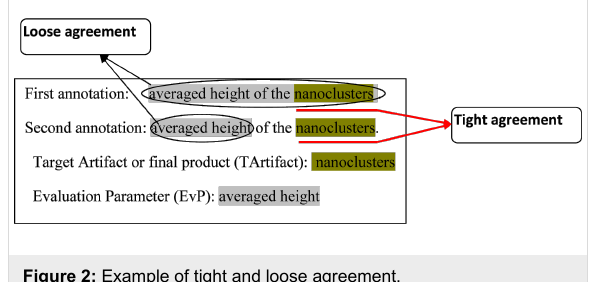
Figure 2: Example of tight and loose